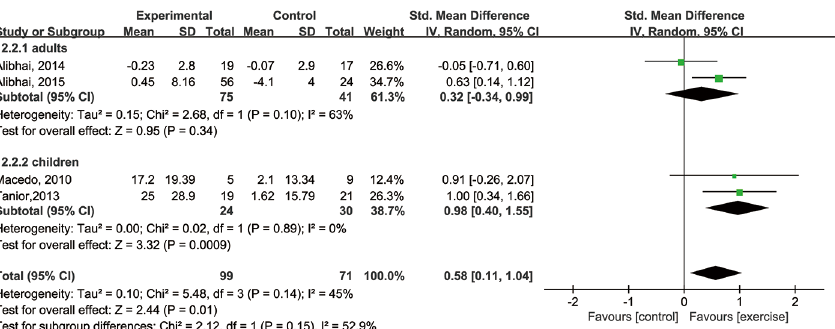
Fig 7. Forest plot of subgroup analyses comparing changes in muscle strength among adults and